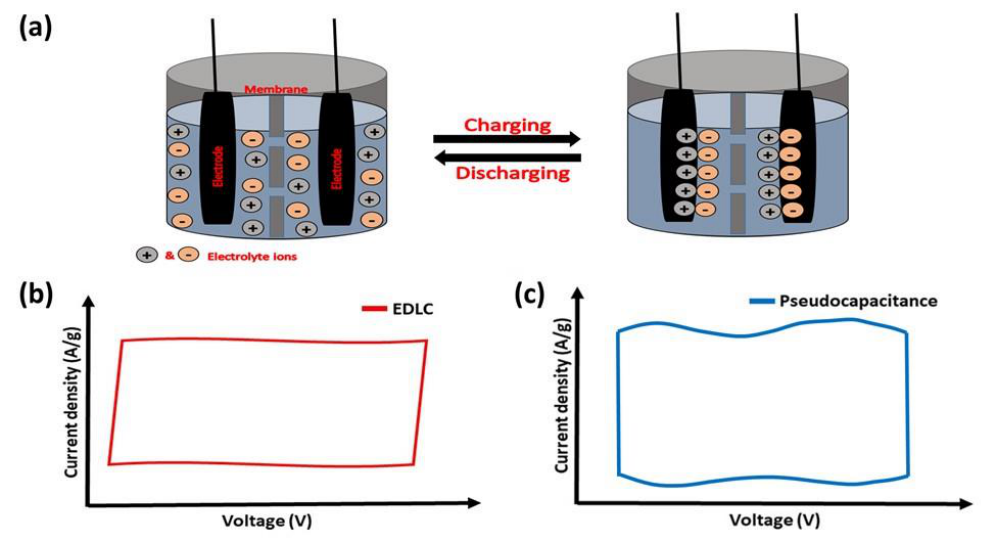
Figure 1. ( a ) Schematic representation showing the energy storage mechanism of EDLC supercapacitors. Representative CVs of ( b ) EDLC and ( c ) pseudocapacitance behaviors.